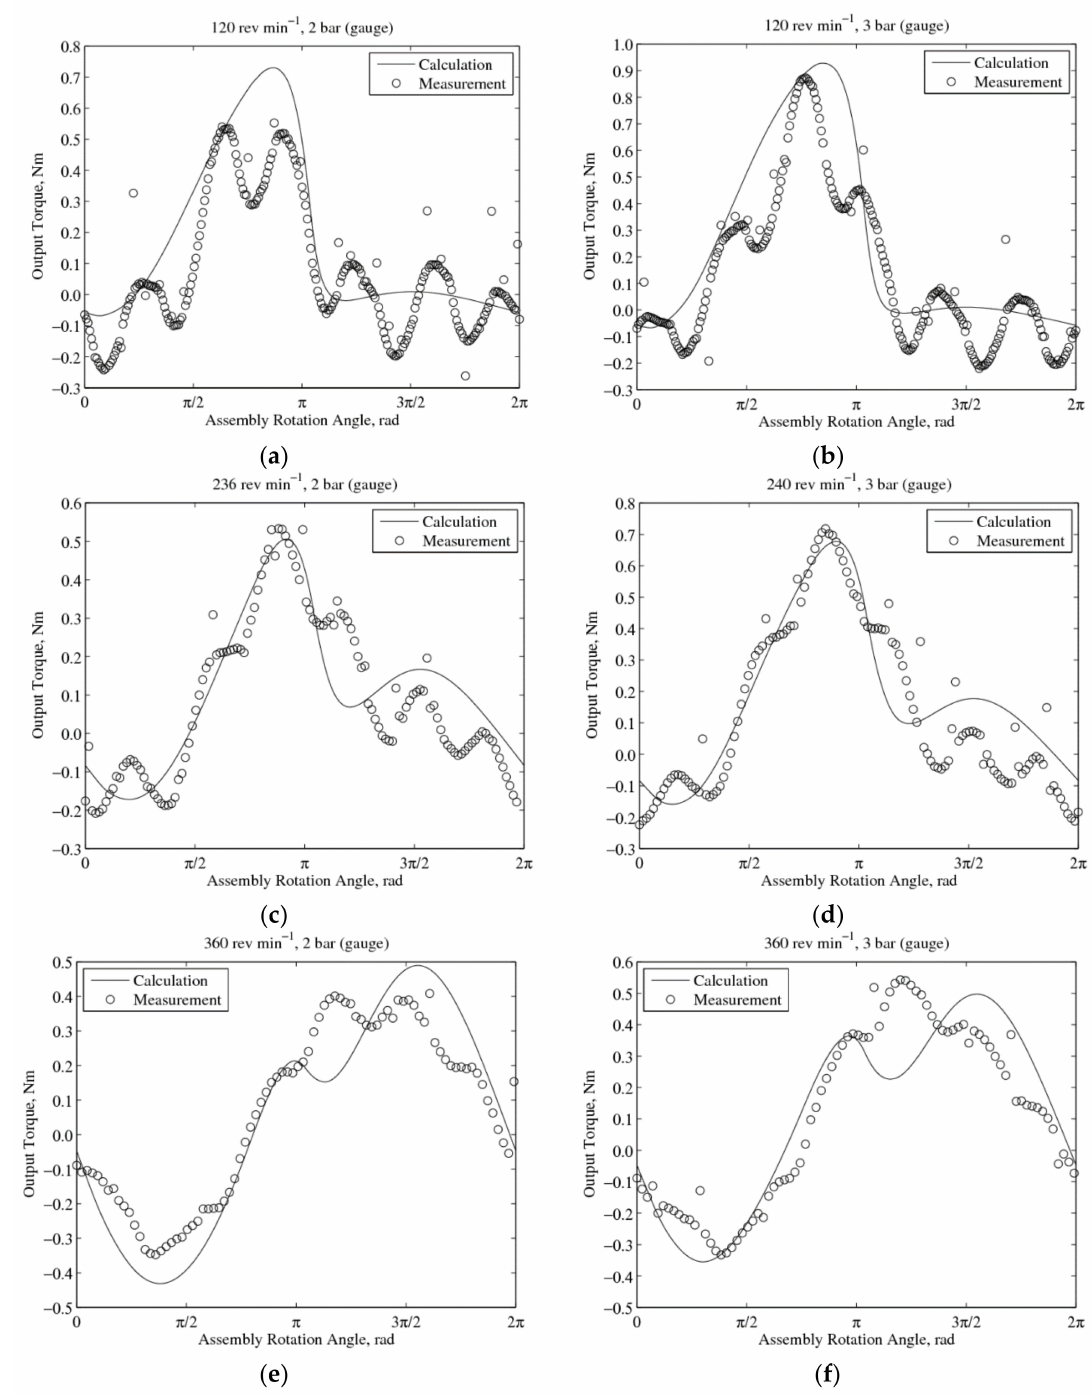
Figure 6. Calculated and measured output torques: ( a ) 120 rev min − 1 with 2 bar (gauge) inlet pressure; ( b ) 120 rev min − 1 with 3 bar (gauge) inlet pressure; ( c ) 236 rev min − 1 with 2 bar (gauge) inlet pressure; ( d ) 240 rev min − 1 with 3 bar (gauge) inlet pressure; ( e ) 360 rev min − 1 with 2 bar (gauge) inlet pressure; ( f ) 360 rev min − 1 with 3 bar (gauge) inlet